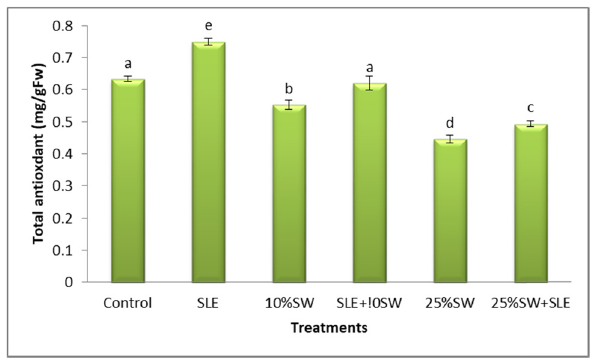
Figure 7: E ff ect of SLE on the total antioxidant contents of T. aestivum L. grown under salt stress. Control – tap water, SW – seawater, SLE – spirulina liquid extracts 2%. The di ff erent letters are signi fi cant ( P ≤ 0.05 ) according to Duncan ’ s multiple